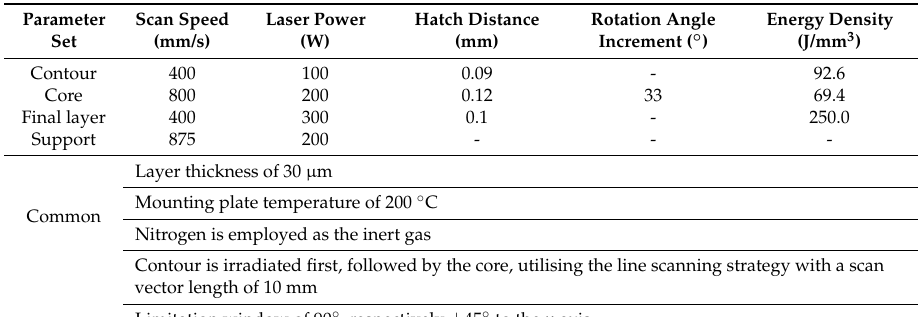
Table 1. Parameter sets utilized for irradiation in SLM for the processing of 1.4404; see description of the parameters and the setup in Figure